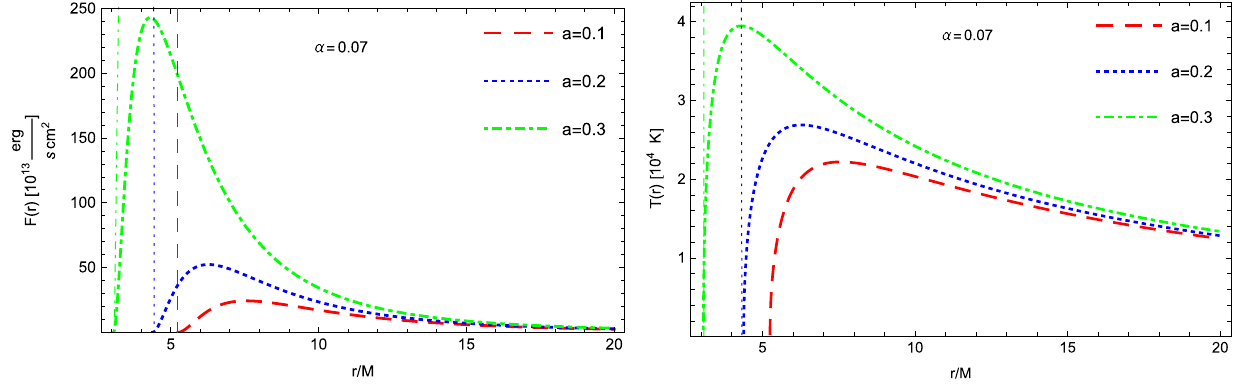
Fig. 6 The energy flux F ( r ) (left panel) and disk temperature T ( r ) (right panel) for a rotating BH in 4 D EGB gravity with mass accretion rate ˙ M = 2 × 10 − 6 M (cid:8) yr − 1 , for different values of rotation parameter